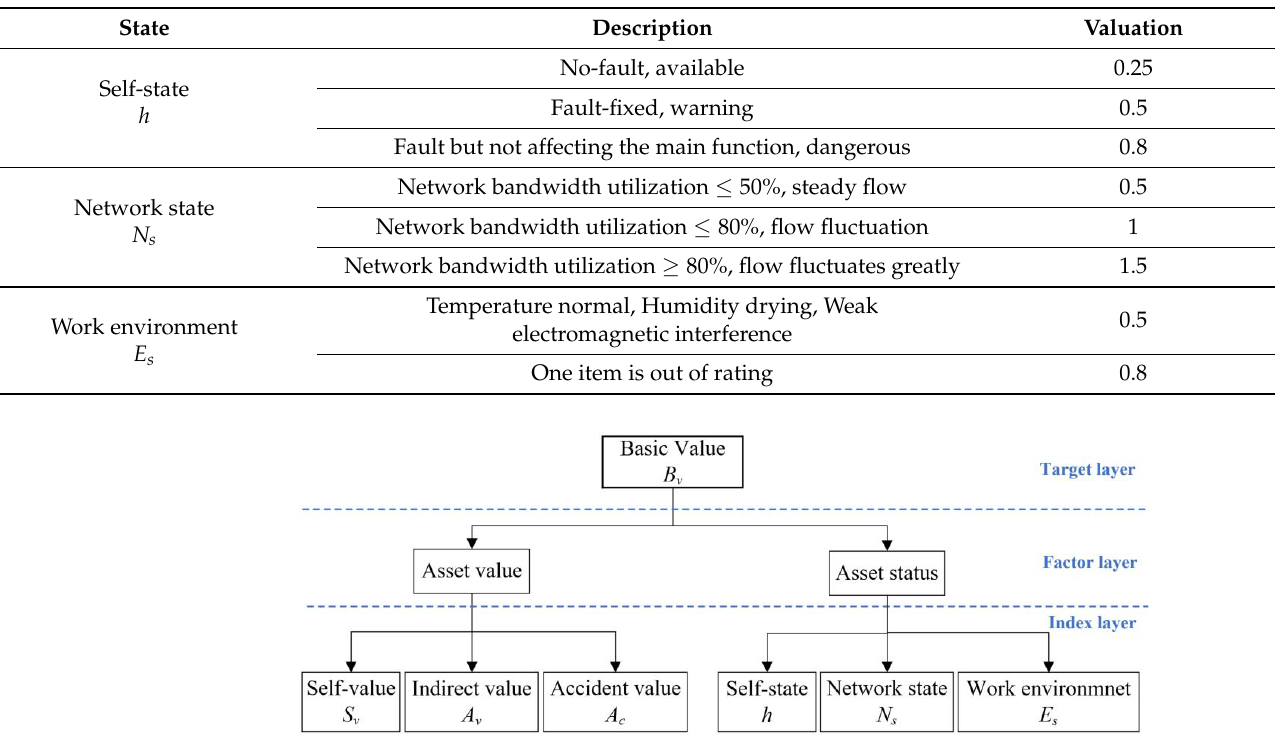
Figure 1. The basic value decomposition